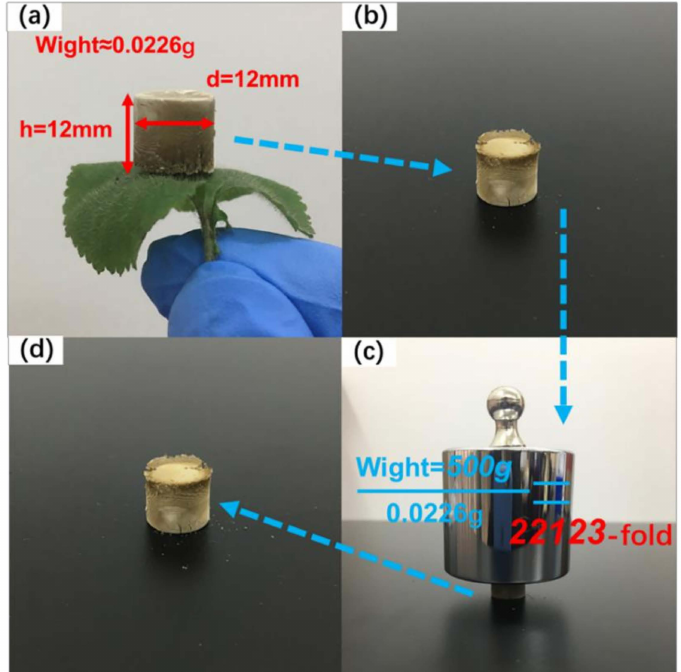
Figure 8. ( a ) Ultra-light cylindrical d-MCPGA supported by young leaves; ( b – d ) the pre, middle and post processes of the d-MCPGA supporting a 500 g mass load.